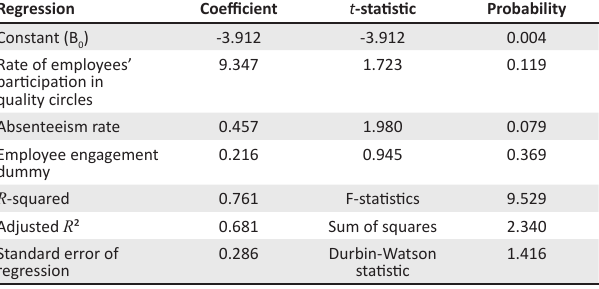
TABLE 4: Labour productivity results on the rate of employee participation in quality circles, absenteeism rate, as well as post-employee engagement dummy. Regression